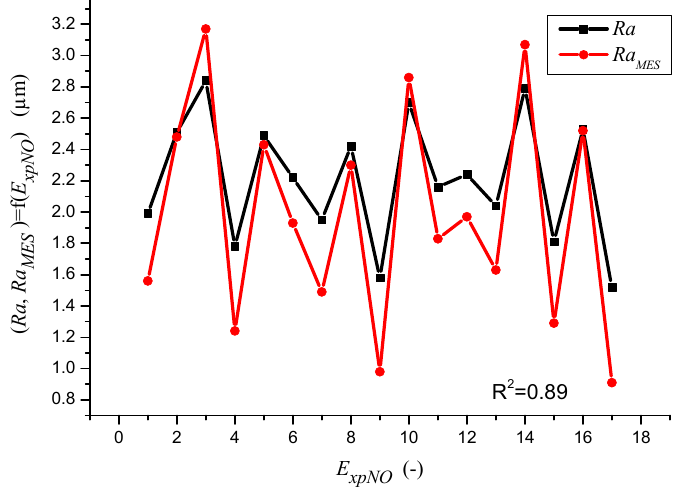
Figure 13. Comparison of parameters Ra , Ra MES = f ( E xpNO ), E xpNo = 1–17 (closeness of conformity R 2 = 0.89. Table 8. Comparation and Verification [10].